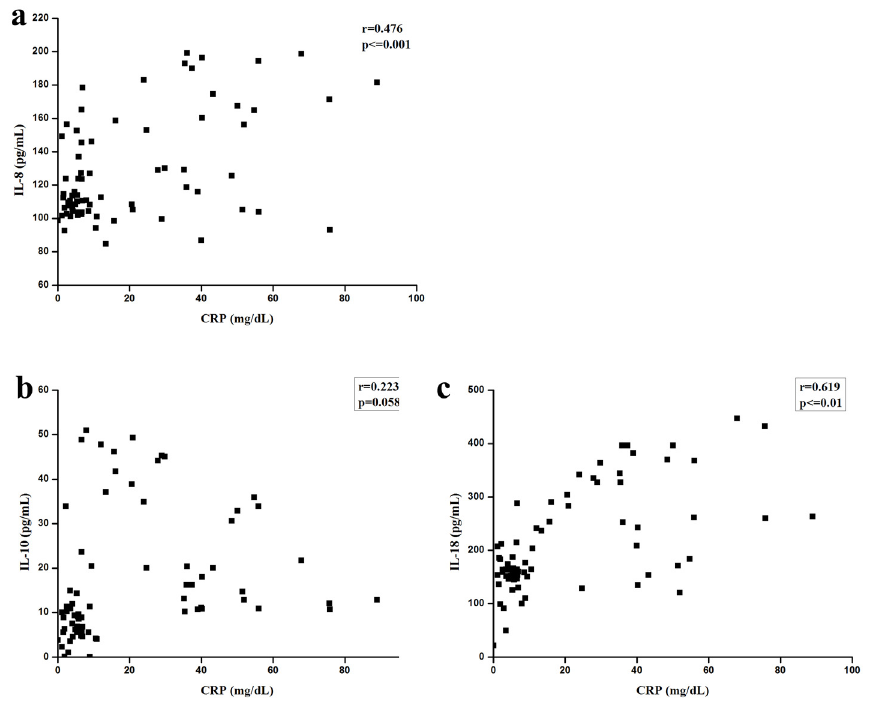
Fig 2. Serum levels of IL-8 (a), IL-10 (b), and IL-18 (c) relationship with CRP. Significant relationships were found between IL-8 levels and CRP levels, as well as between IL-18 levels and CRP levels, although no significant relationship was found between IL-10 and CRP